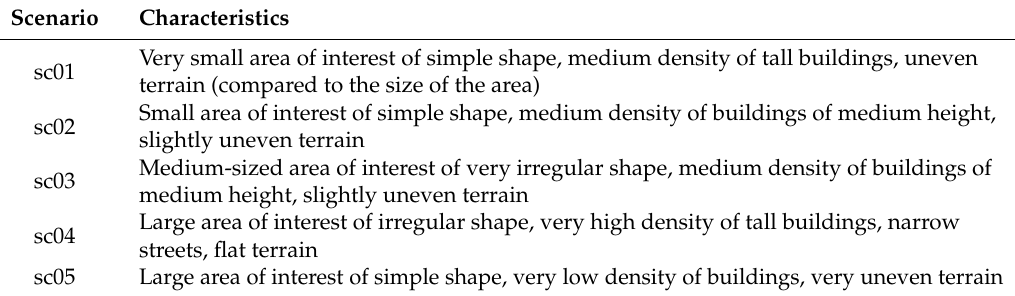
Table 2. Characteristics of